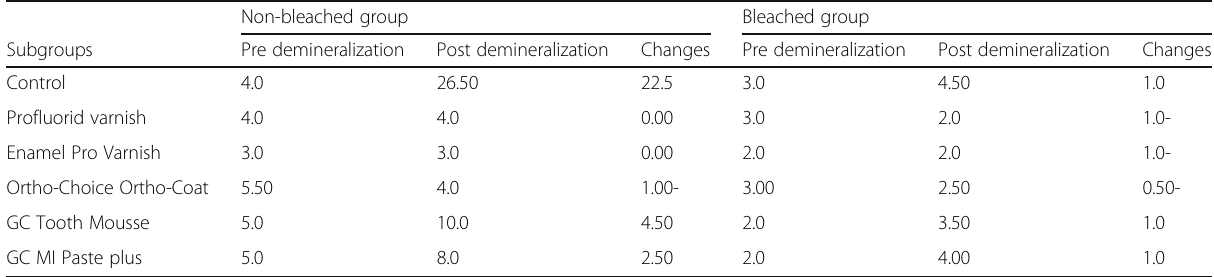
Table 1 Medians of DIAGNOdent values for different bleached and non-bleached